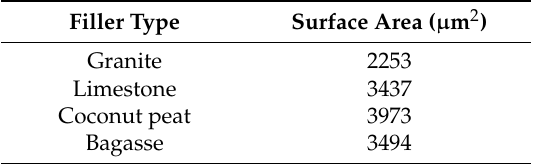
Table 2. The estimated surface area through SEM